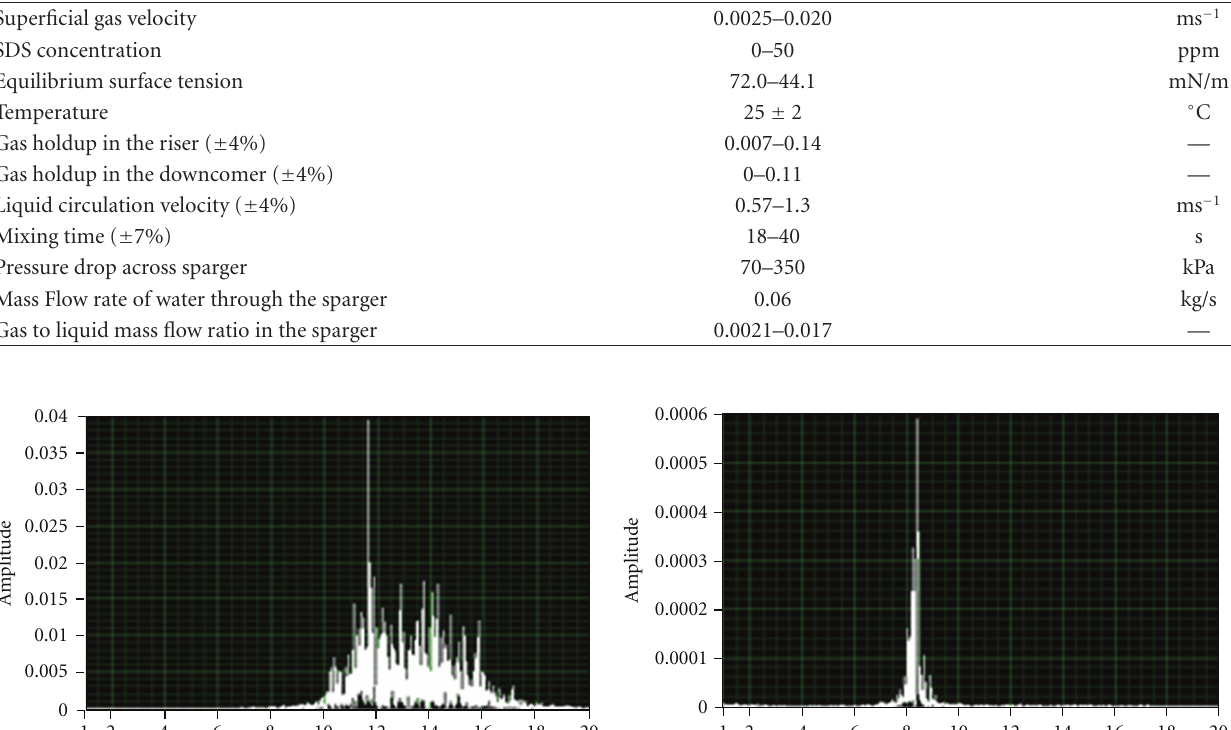
Table 2: Range of experimental conditions investigated.